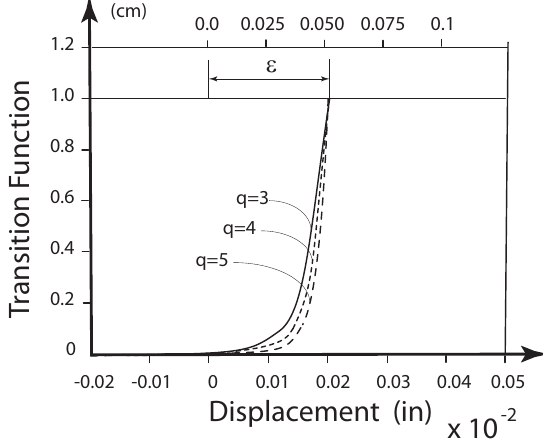
Figure 3. Transition function T 2 [48].